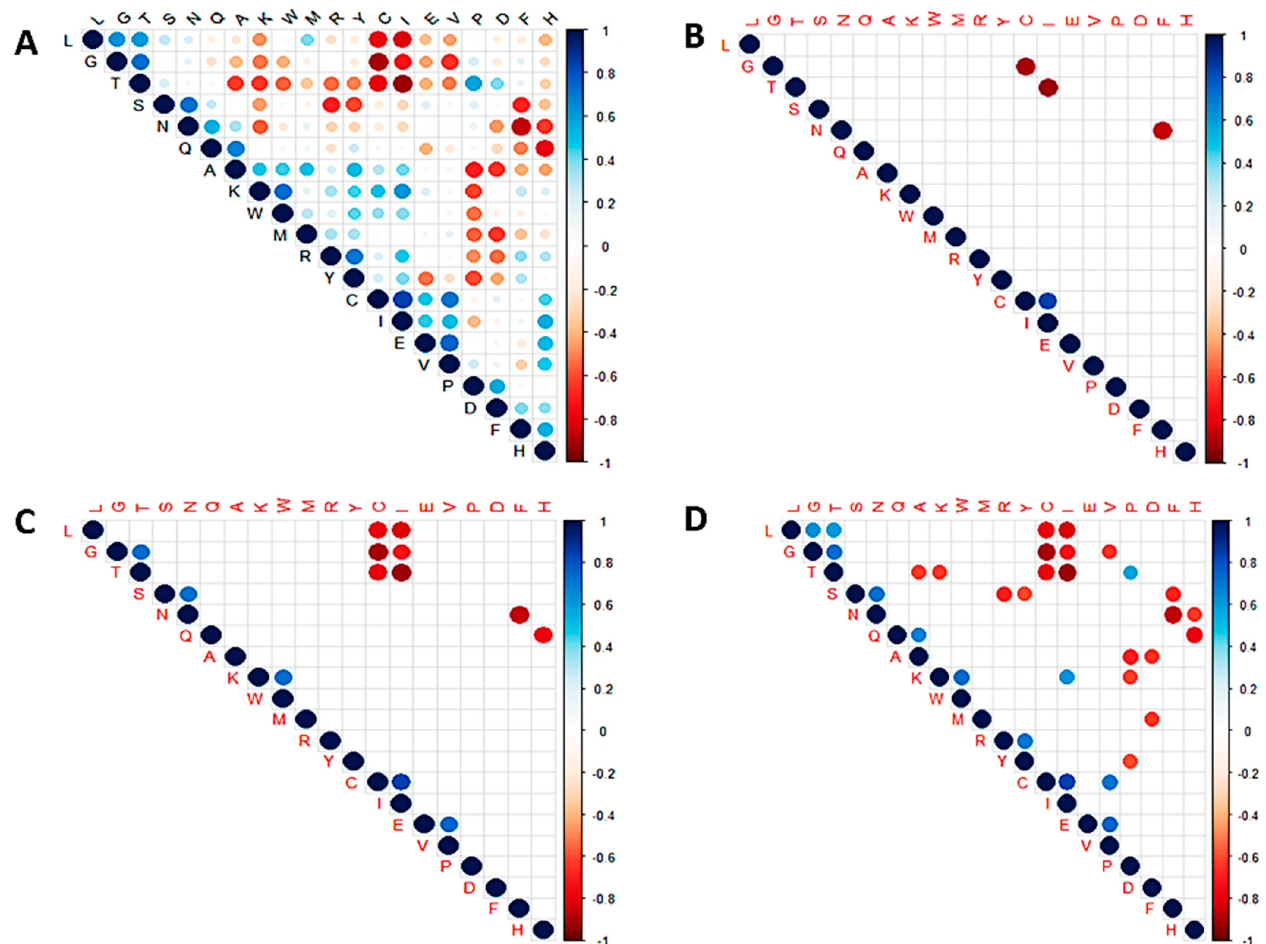
Figure 4. Correlation plots showing the relationship among the 20 standard amino acids of SARS- CoV-2 at ( A ) no p -value, ( B ) p < 0.001, ( C ) p < 0.01, and ( D ) p < 0.05. CoV-2 at ( A ) no p -value, ( B ) p < 0.001, ( C ) p < 0.01, and ( D ) p <